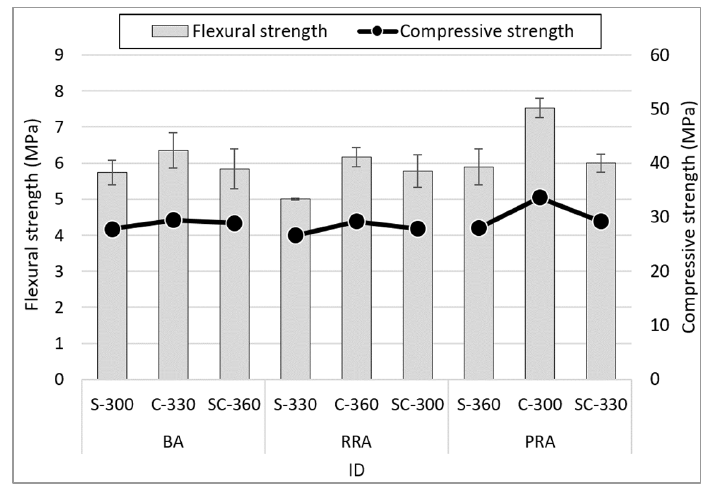
Figure 10. Flexural strength of the concrete.